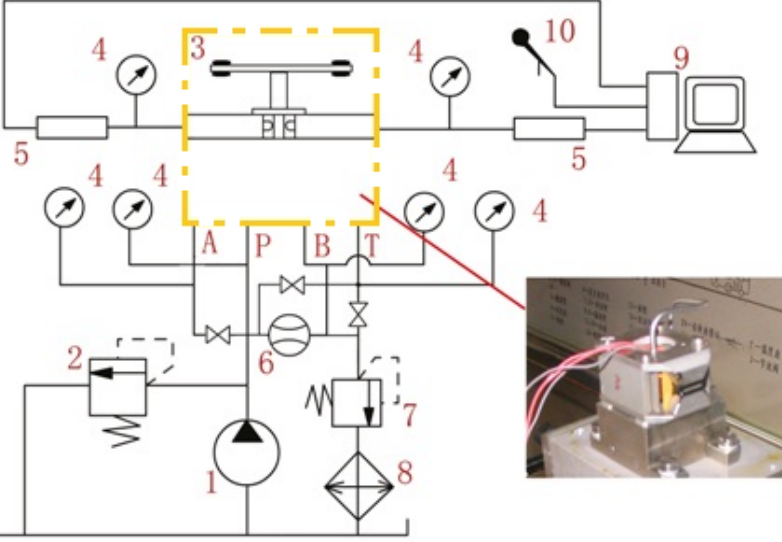
Figure 7. Experimental setup for self-excited noise and the tested servovalve with magnetic fluids. (1) Hydraulic pump; (2) relief valve; (3) tested servovalve with or without MF; (4) pressure gauge; (5) pressure sensor; (6) flow rate meter; (7) back pressure valve; (8) cooler; (9) computer with acquisition systems; (10) sound sensor.